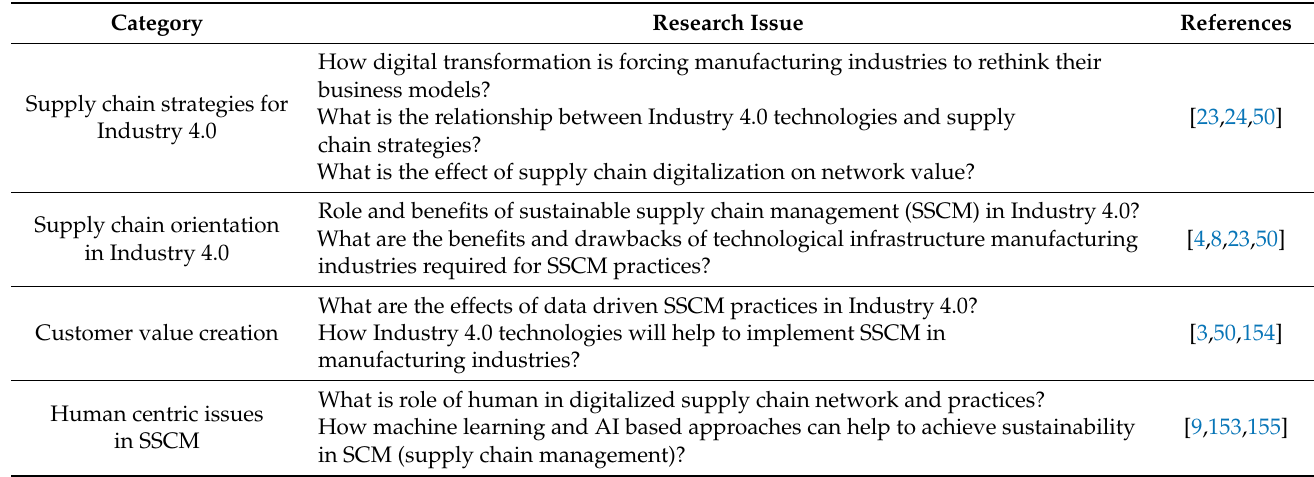
Table 5. Research issues in sustainable supply chain practices in Industry 4.0 for manufacturing